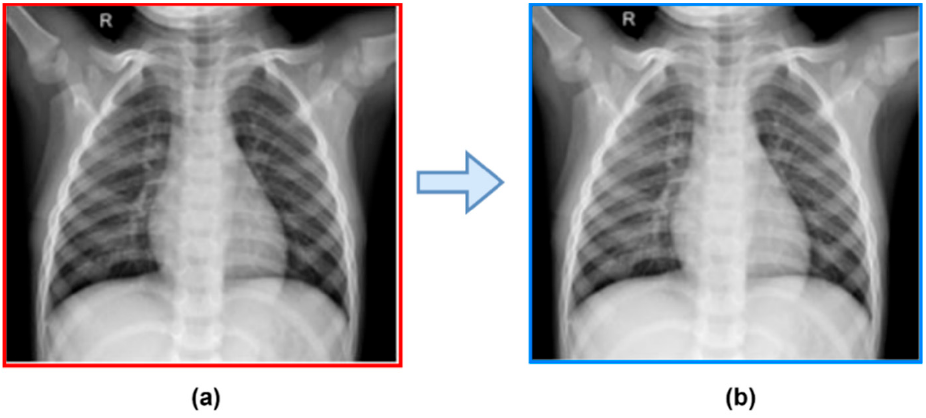
Figure 4. Contrast enhancement and smoothing image: ( a ) Raw image ( b ) Enhanced